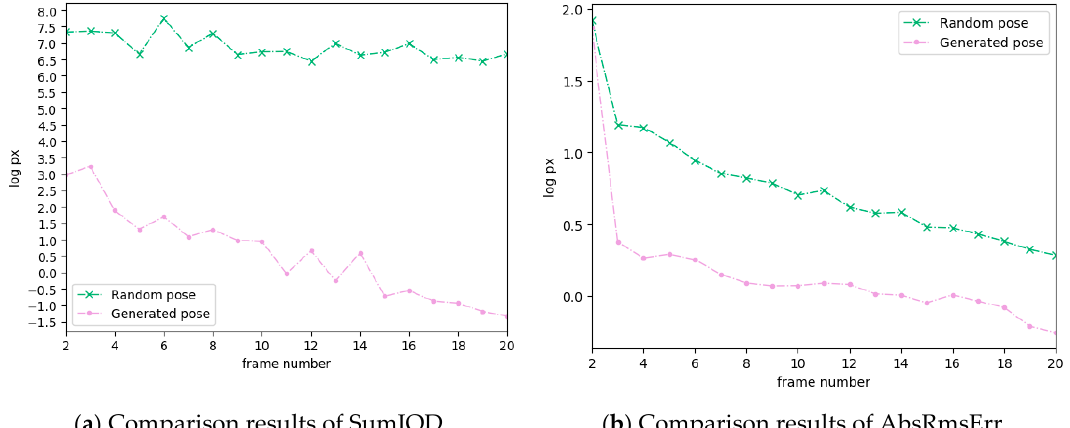
Figure 9. Random pose vs. Generated pose. The green dotted line is generated by the pose search algorithm with Random pose as the initial solution. The magenta dotted line is obtained by the pose search algorithm with a generated pose as the initial solution. Both methods use AbsRmsErr as the loss function.